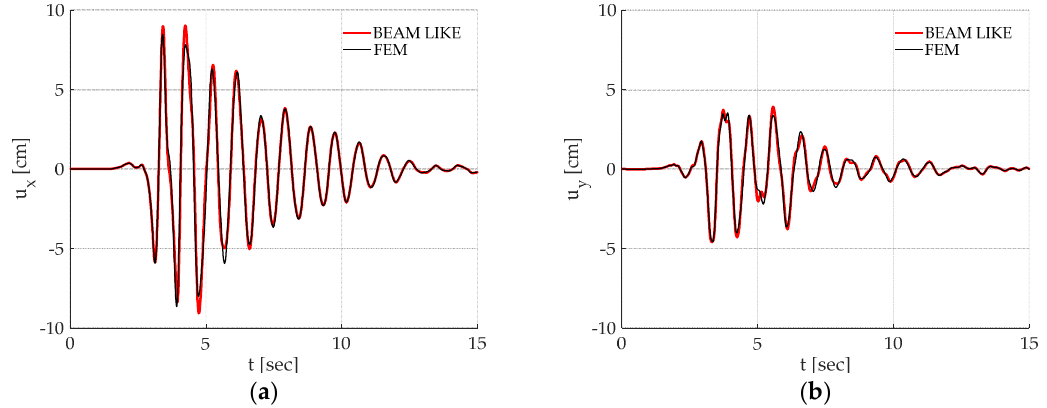
Figure 13. Eight-storey benchmark. Santa Venerina earthquake. Displacements time history along the ( a ) x and ( b ) y direction.